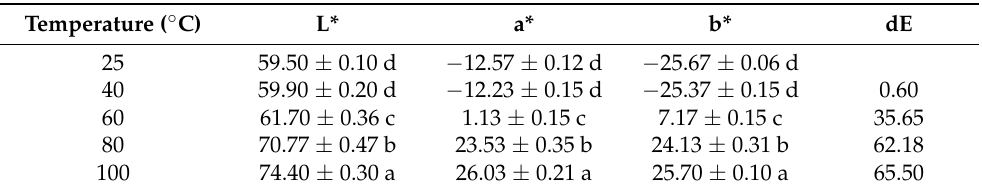
Figure 6. Tertiary structure modelling of PcCRA2. ( a ) Tertiary structure comparison between PcCRA2 (green) and the template H. gammarus crustacyanin A2 (yellow). ( b ) Molecular docking diagram of astaxanthin and PcCRA2. ( c ) Key amino acid binding analysis of PcCRA2 and astaxanthin. Table 2. Colour changes of F1 (1 mg · mL − 1 ) after the heat treatment at different temperatures (25, 40, 60, 80, or 100 ◦ C) for 10